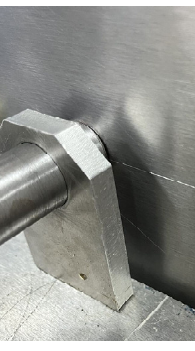
Figure 14. Position aligning between end effector and specimen.